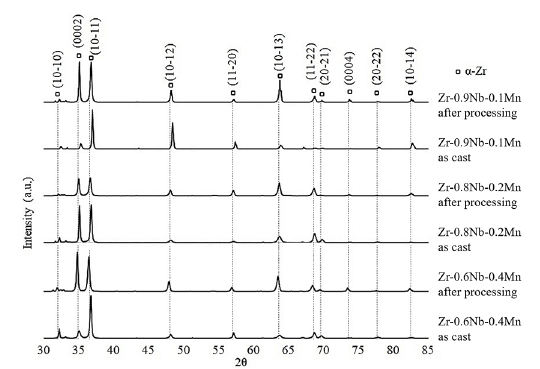
Figure 3. XRD pattern of the Zr-0.9Nb-0.1Mn, Zr-0.8Nb-0.2Mn and Zr-0.6Nb-0.4Mn alloys as cast and after the thermomechanical